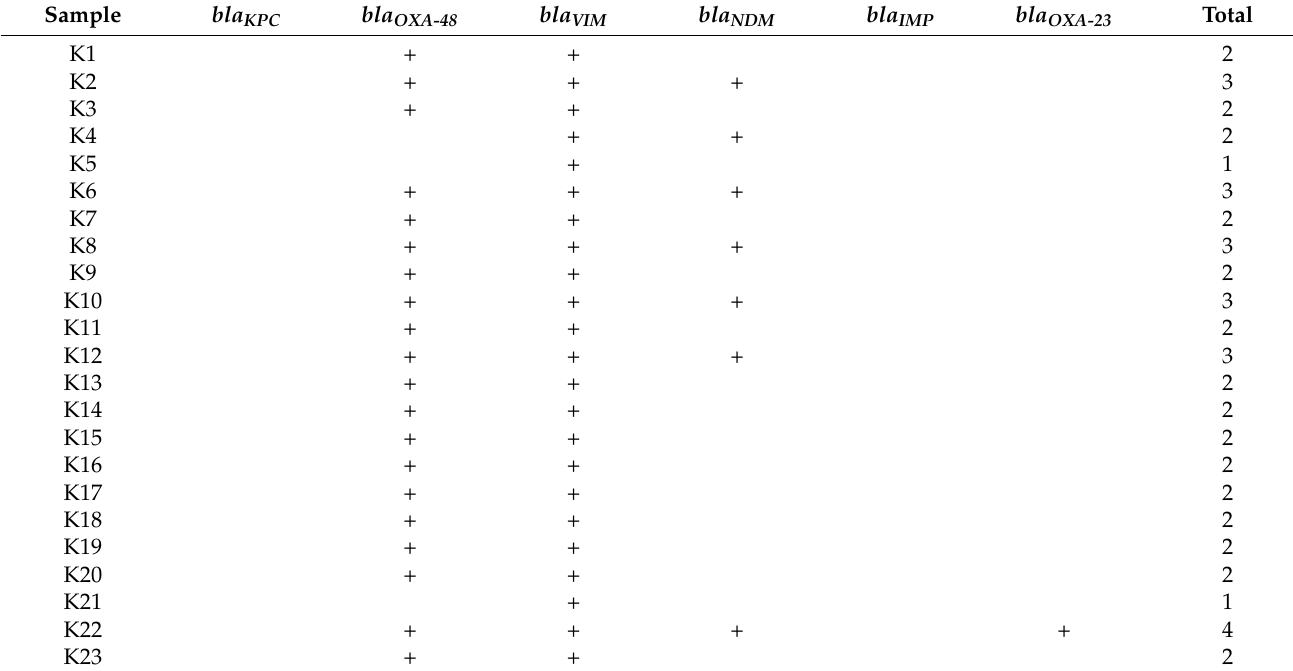
Table 5. Detection of carbapenemase genes in 23 isolates.